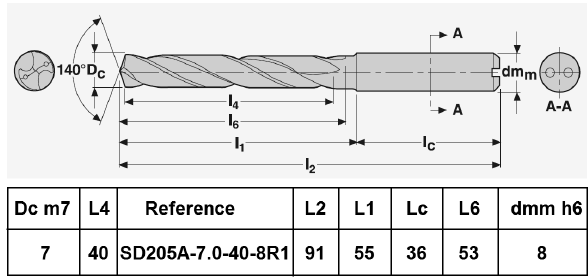
Figure 2. Characteristics of the drill used.